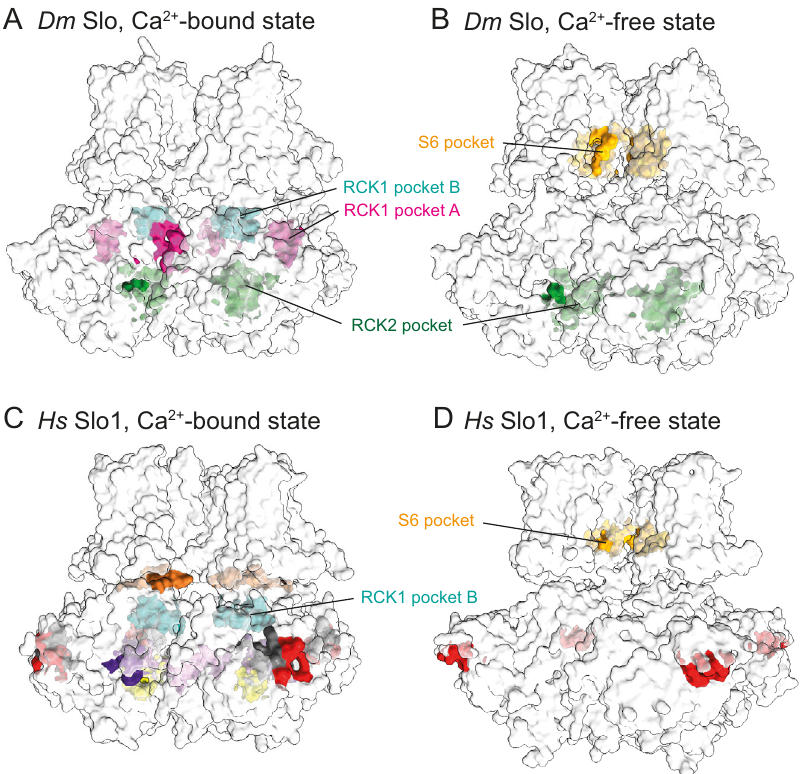
Fig. 2 Identi fi cation of potential drug-binding pockets on Drosophila Slo. A , B Location of potential drug-binding pockets on the Ca 2 + -bound (panel A ) and Ca 2 + -free (panel B ) conformations of Drosophila Slo. BiteNet 37 identi fi ed two sites in the RCK1 domain which are de fi ned by residues of the neighboring (pocket A, pink) or the same (pocket B, cyan) subunit and were only identi fi ed in the Ca 2 + -bound conformation. A third pocket is present in the RCK2 domain in both conformations (green). Furthermore, an S6 pocket speci fi c to the closed state is present in the cavity within the TM domain (yellow). C , D Location of potential drug-binding pockets on the Ca 2 + -bound active (panel C ; PDB 6V38) and the Ca 2 + -free inactive (panel D ; PDB 6V3G) conformations of human Slo1. In addition to the RCK1 pocket A and the S6 pocket that have also been identi fi ed in Drosophila Slo, several additional pockets have been identi fi ed in the gating ring (highlighted in red, gray, purple, violet, and yellow) and along the linker connecting TMD and gating ring emodepside, which affects Slo with an IC 50 in the low μM range (Supplementary Fig. 6A), Drosophila Slo is insensitive to the regulation by Ca 2 + concentrations and transmembrane voltage